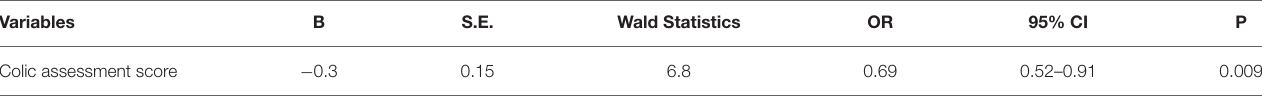
TABLE 5 | Univariate logistic regression for the colic assessment score to predict survival in the prospective study. Variables